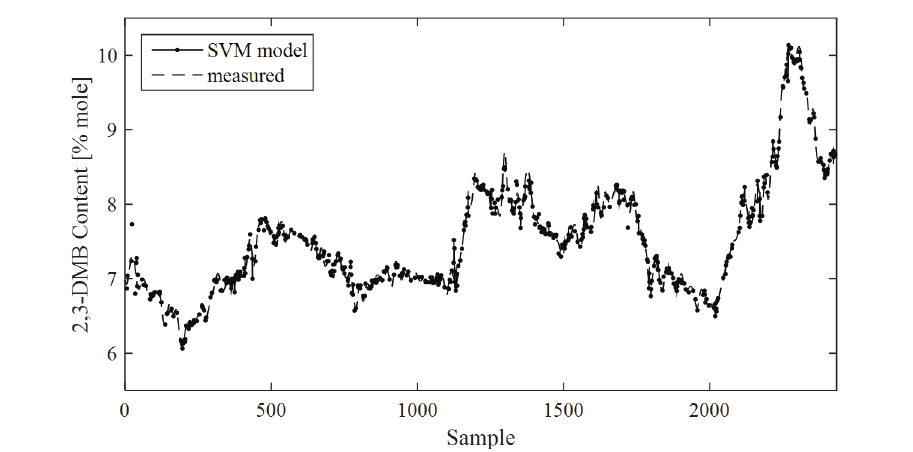
Fig. 10 – Comparison between measured data and 2,3-DMB content SVM model